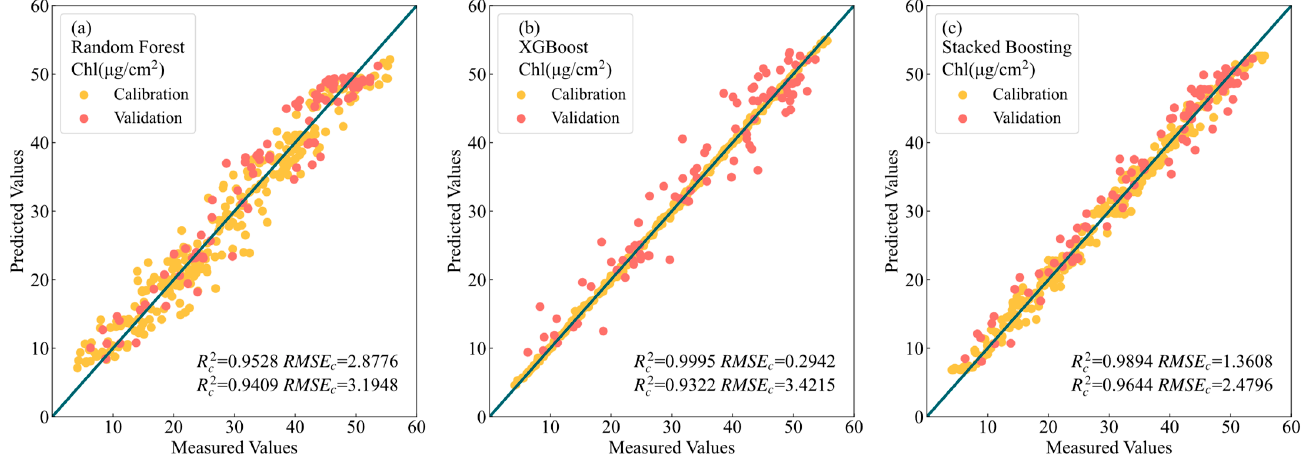
Figure 10. Prediction results of ( a ) Random Forest; ( b ) XGBoost; ( c ) Stacked–Boosting.